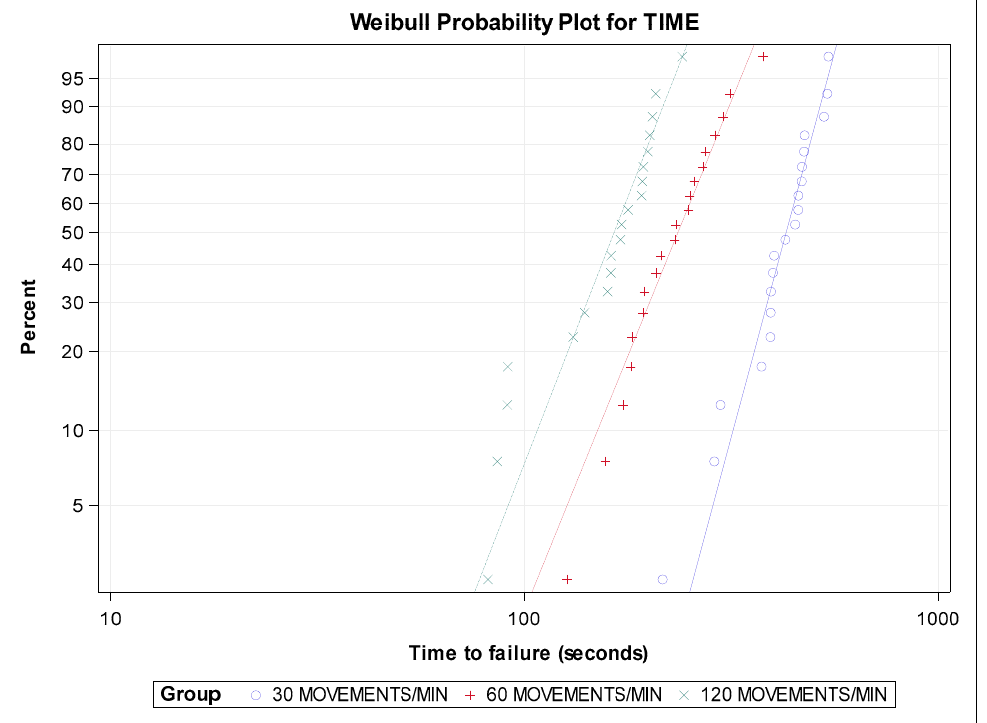
Figure 6. Boxplots of the NCF of the experimental groups. The horizontal line in each box represents the median value.